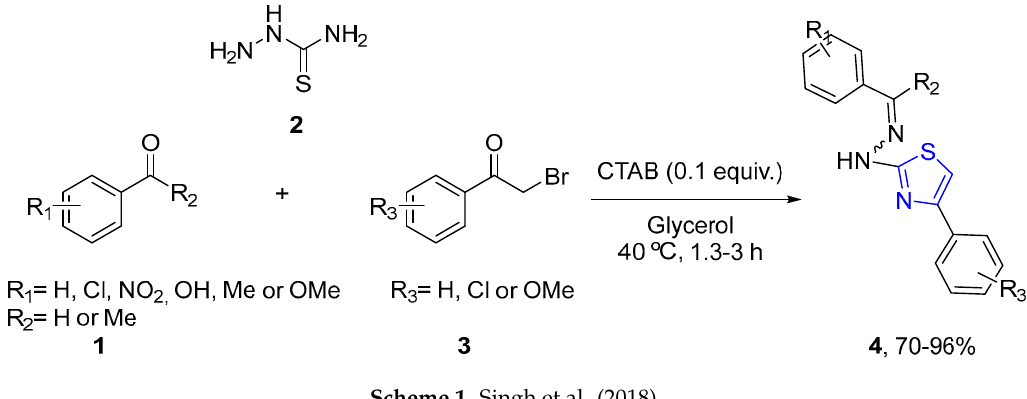
Scheme 1. Singh et al. (2018).